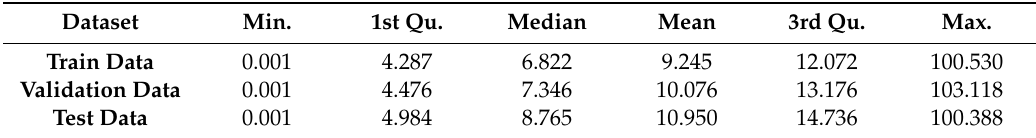
Table 3. Statistics of Training, Validation, and Test Sets, in